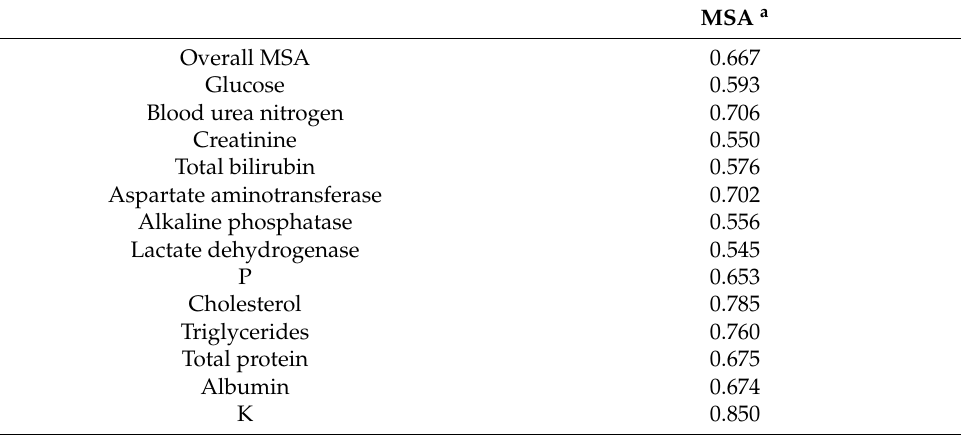
Table 3. Kaiser–Meyer–Olkin test results.